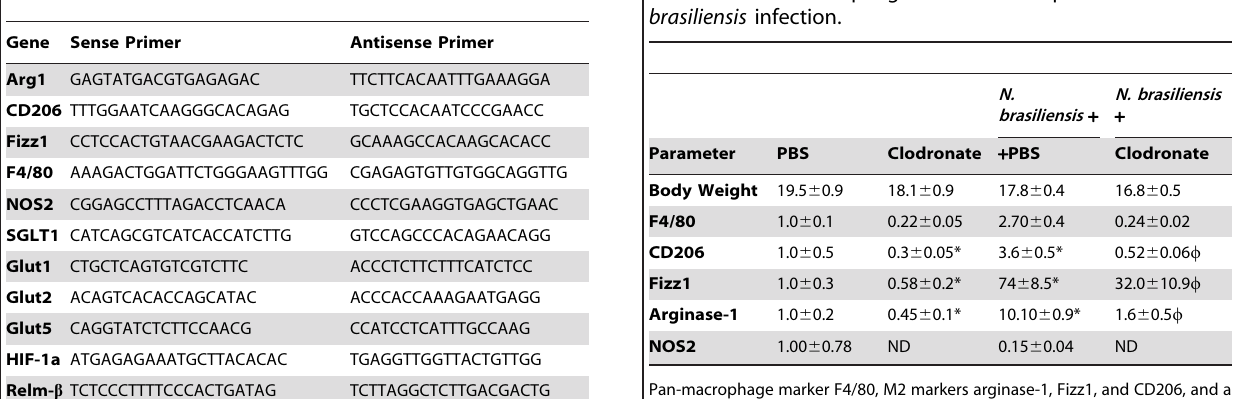
Table 2. Effect of PBS- or clodronate-containing liposomes on body weight (in grams) and gene expression (fold change) of M1 and M2 macrophage markers in response to